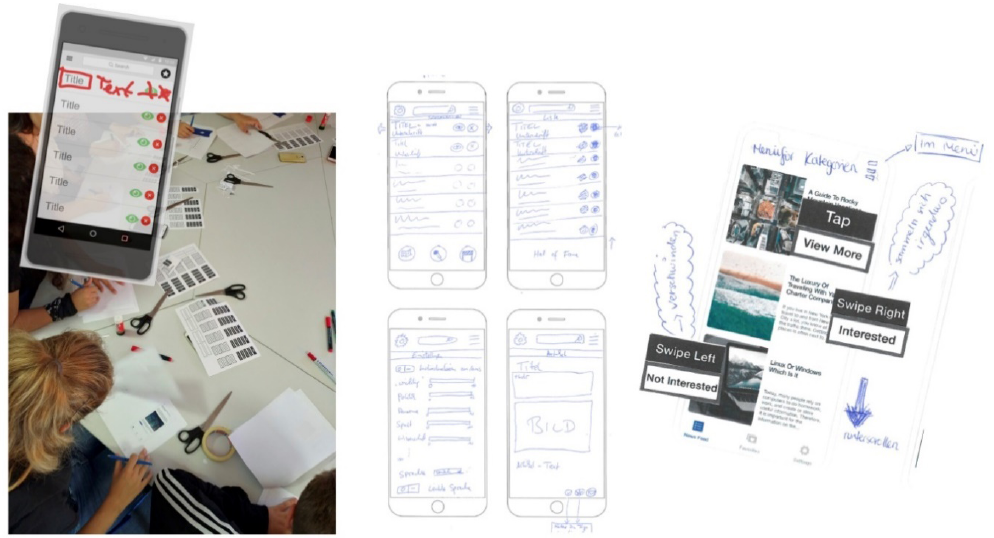
Figure 1. Example of a co-creation workshop.